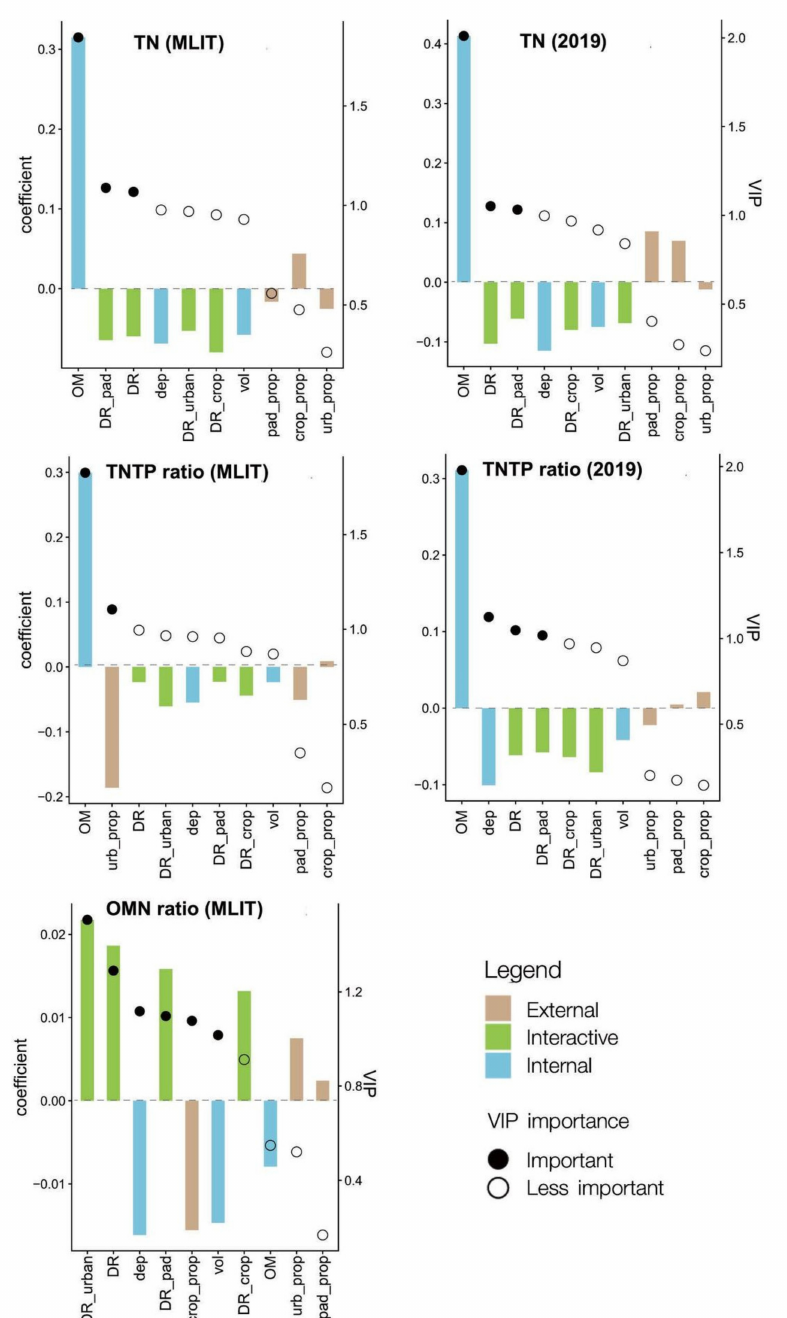
Figure 4. Partial least squares regression (PLS) output for total nitrogen (TN), nitrogen to phosphorus (TNTP ratio) ratio and organic matter to nitrogen (OMN ratio) ratio in MLIT data and 2019 data. Variables are listed with regression coefficients in descending VIP (variable importance to the projec- tion) index order. VIP > 1 is considered important (filled circles) and VIP < 1 is less important (open circles). For abbreviations, OM for organic matter and see Figure